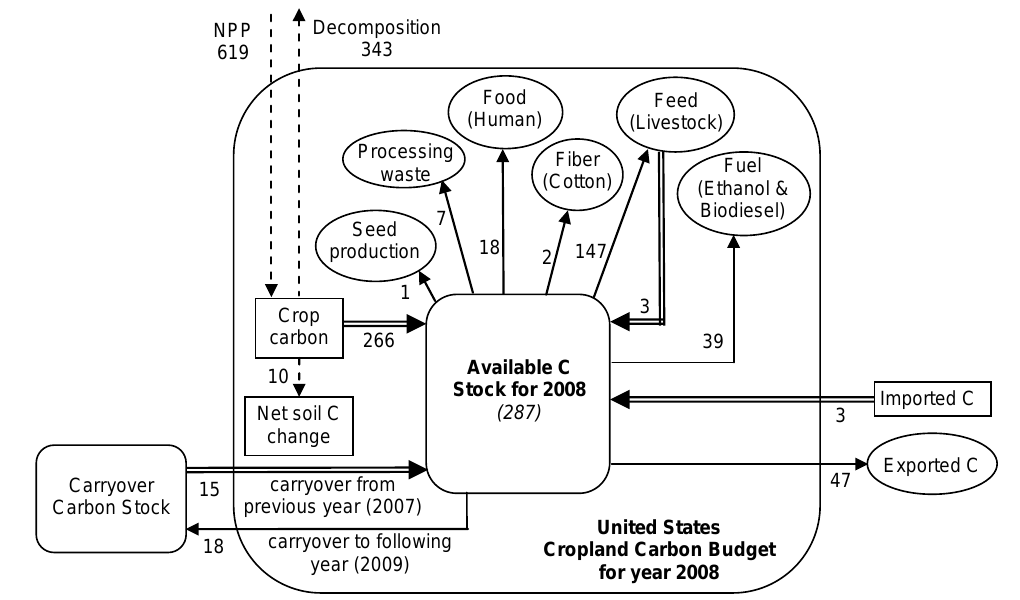
Fig. 1. Cropland carbon budget for the contiguous US. This budget represents the movement of annual crop carbon into, out of, and within the US for the year 2008. Double arrows represent inputs to the annual crop carbon stock that are available for food, feed, fiber, and fuel; single arrows represent flows of carbon that lessen the available crop carbon stock; and dashed arrows represent initial photosynthetic production of crop carbon and estimated net soil carbon accumulation. Ellipses represent end uses of crop carbon. All units are in TgCyr − 1 .